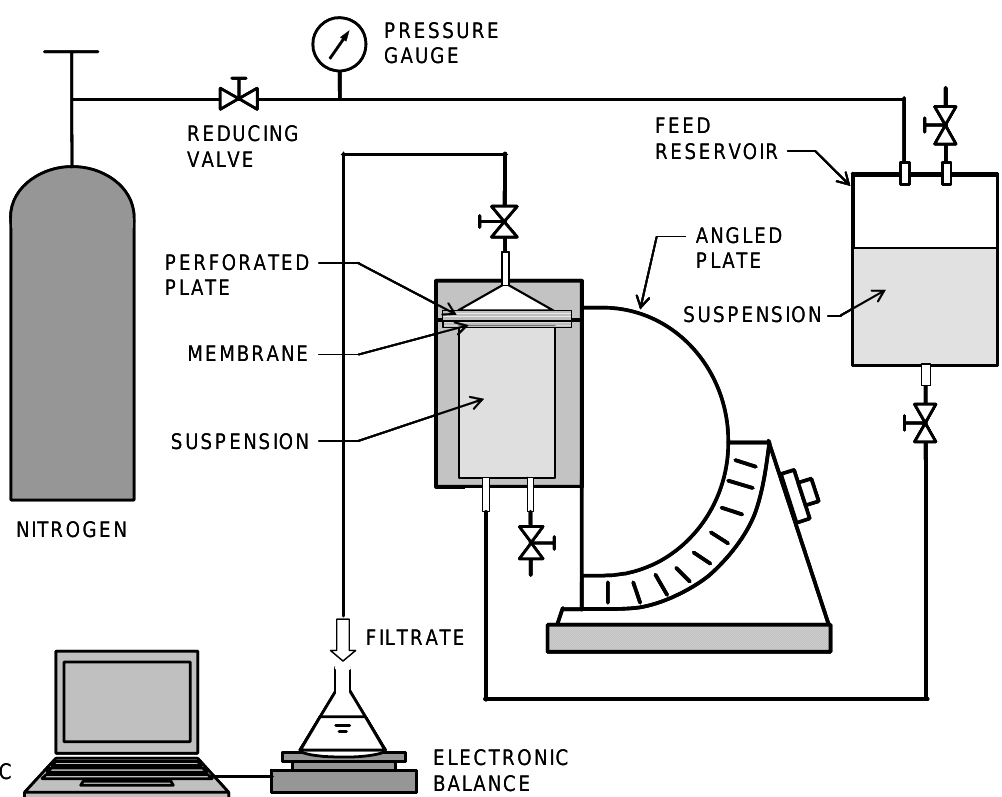
Figure 2. Schematic diagram of upward UF